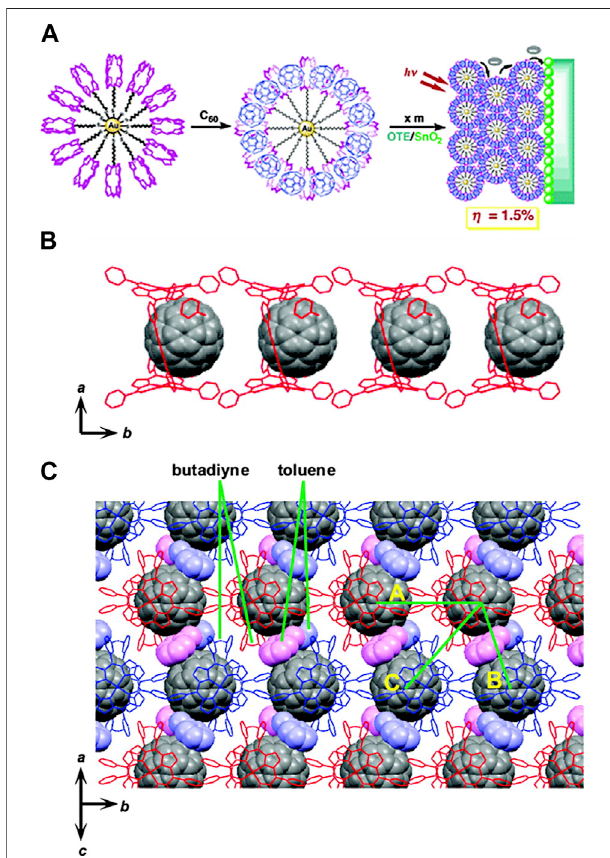
FIGURE 11 | (A) Composite nanoclusters of porphyrins covalently bound togoldnanoparticles withfullerenesasacceptor molecules inbetween each porphyrin. Figure taken from Kamat et al. (Hasobe et al., 2005), crystal structures of tubular assemblies of a C 60 ⊂ Ni 2 − CPDPy donor-acceptor complex. Hydrogen atoms are omitted for clarity: (B) side view; (C) top view (Reprinted (adapted) with permission from Nobukuni et al., 2009. Copyright 2009 American Chemical